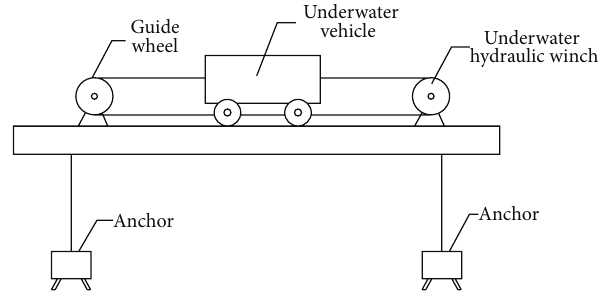
Figure 1: Schematic diagram of underwater vehicle propelled by hydraulic